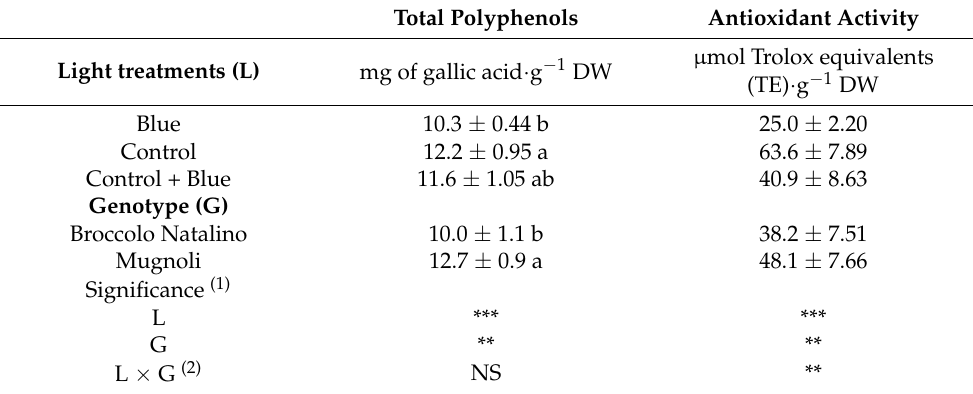
Table 5. Polyphenols content and antioxidant activity, expressed as dry weight (DW), of two brassica microgreens (Broccolo Natalino and Mugnoli) cultivated in a growth chamber with three different light spectra: Blue (B), Control (CTRL), and Control + Blue (CTRL + B). Means followed by different letters within a column indicate significant differences according to Student–Newman–Keuls (SNK) test at p = 0.05.